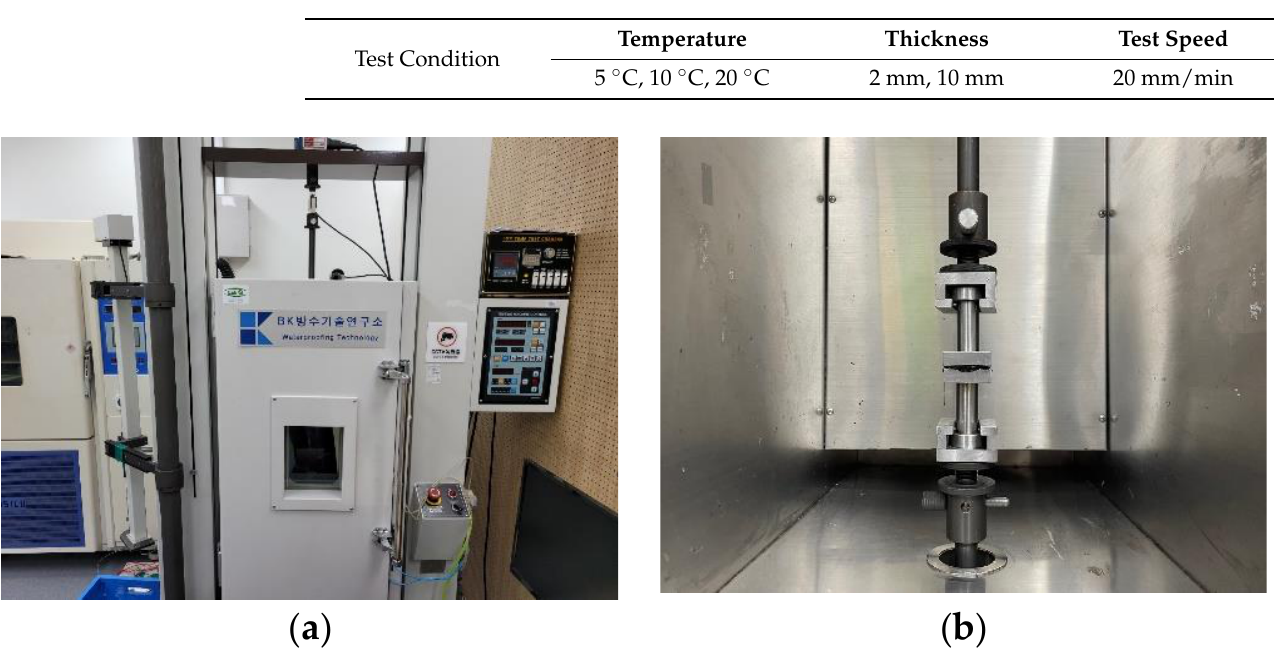
Table 3. Measurement result based on specimen types (2 mm thickness).